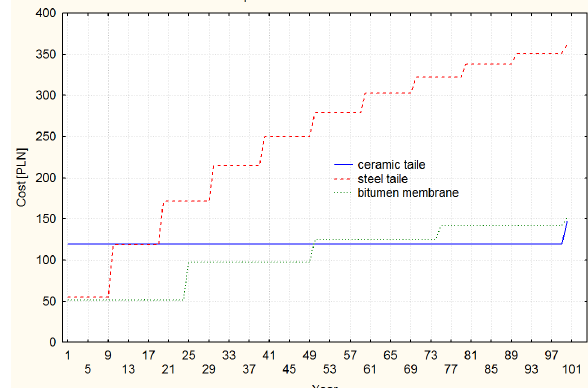
Figure 1: The cost of installing and using roof coverings over a